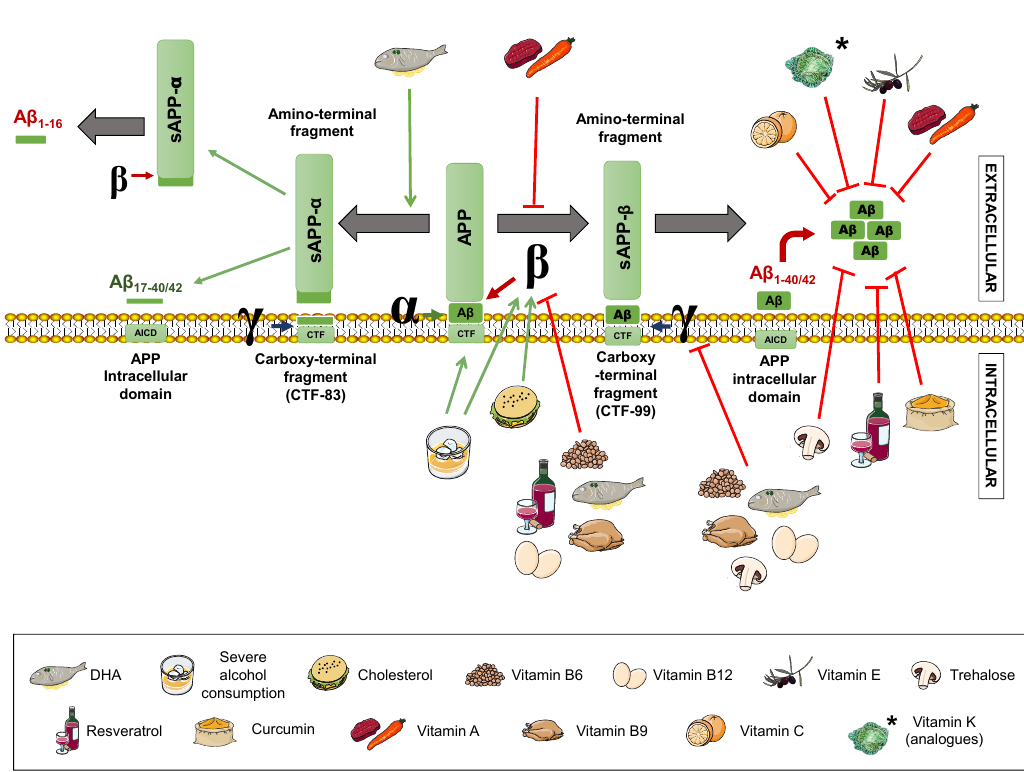
Figure 1. Amyloid precursor protein (APP) processing pathways and its modulation by different nutrients. The non-amyloidogenic pathway ( A ) occurs upon sequential cleavage by α - and γ -secretases (non-pathological situation) or by α - and β -secretases (pathological situation), while the amyloidogenic route ( B ) occurs when cleavage is carried out sequentially by β - and γ -secretases. Letters α , β , and γ represent each secretase. APP: amyloid precursor protein. sAPP α : soluble α -APP. sAPP β : soluble β -APP. Nutrients that are proposed to interfere with APP processing are shown in the legend. Green arrows represent activation. Red truncated arrows show